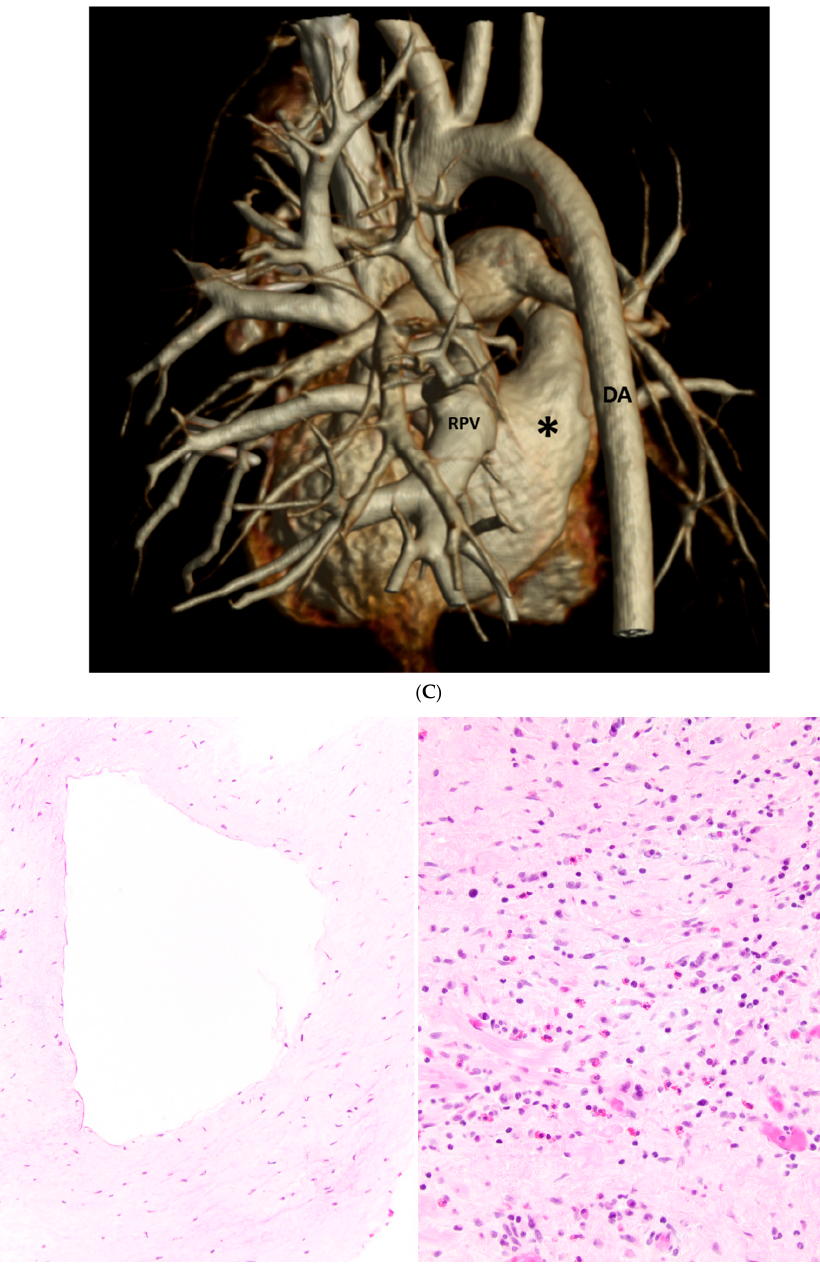
Figure 2. A 13-month-old male with secondary pulmonary vein stenosis due to total anomalous pulmonary venous connection repair who presented with hypoxemia. ( A ) Axial contrast-enhanced thoracic MDCT angiography CT image shows ill-defined, mildly heterogeneously enhancing, non-calcified soft tissue mass (asterisk) in the expected location of the left proximal pulmonary vein. Left proximal pulmonary vein is absent. Similar abnormal soft tissue (arrowheads) surrounding left pulmonary vein with decreased size is seen more distally. Right pulmonary vein (RPV) is patent. LA = left atrium. ( B ) Coronal contrast-enhanced thoracic MDCT angiography CT image demonstrates ill-defined, mildly heterogeneously enhancing, non-calcified soft tissue mass (arrowheads) along the narrowed left pulmonary vein. Right pulmonary vein (RPV) is patent. ( C ) 3D volume-rendered vascular reconstruction CT image in the posterior projection view shows absent left pulmonary vein in the expected location (asterisk). Patent right pulmonary vein (RPV) is seen. DA = descending aorta. ( D ) Pulmonary vein biopsy obtained at age 14 months shows circumferential intimal fibromyxoid proliferation (left panel; original magnification, 20 × ) and extravascular/adventitial foreign-body giant-cell reaction (not shown), fibrosis, and a cellular inflammatory infiltrate comprised of lymphocytes, plasma cells, eosinophils, and histiocytes (right panel; original magnification, 40 × ). Hematoxylin and eosin stain in both Table 2. The main pulmonary artery to ascending aorta ratios ranged from 1.1 to 2.19 (mean, 1.45; SD, 0.32). Table 2. Main Pulmonary Artery (Pulmonary Trunk) to Ascending Aorta Ratio.